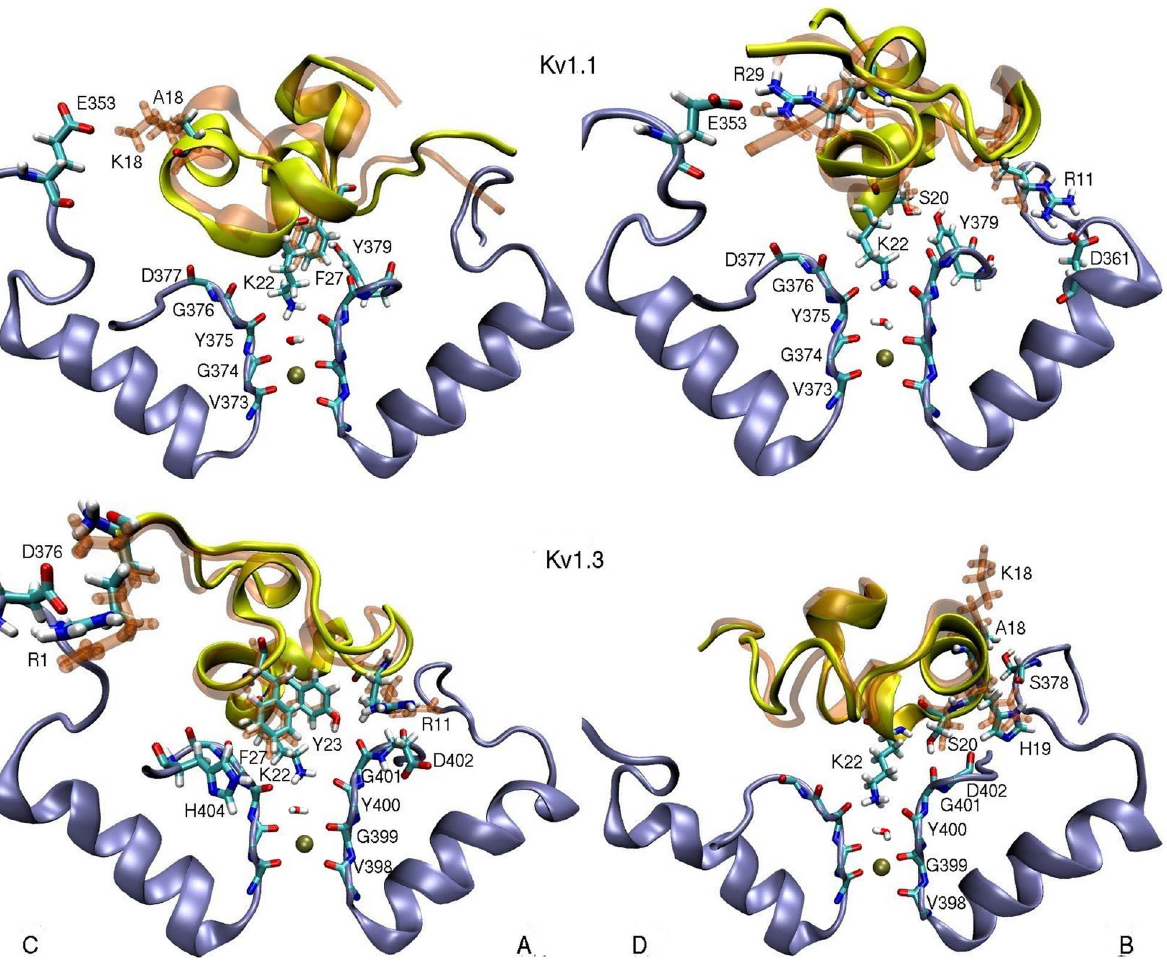
Figure 2. The K18A mutation does not change the binding modes of ShK to Kv1.1 and Kv1.3 channels. Snapshots of ShK[K18A] (yellow with colored side chains) and ShK (transparent orange) in complex with Kv1.1 and Kv1.3 are superposed to show that there is a good overlap between the toxin backbones, and all the important interactions identified in the ShK complexes are preserved in the ShK[K18A] complexes. To give the full picture, two views of the cross sections of the complex, depicting the monomers C and A (left panel) and D and B (right panel) are presented. Only the residues involved in binding are indicated explicitly.